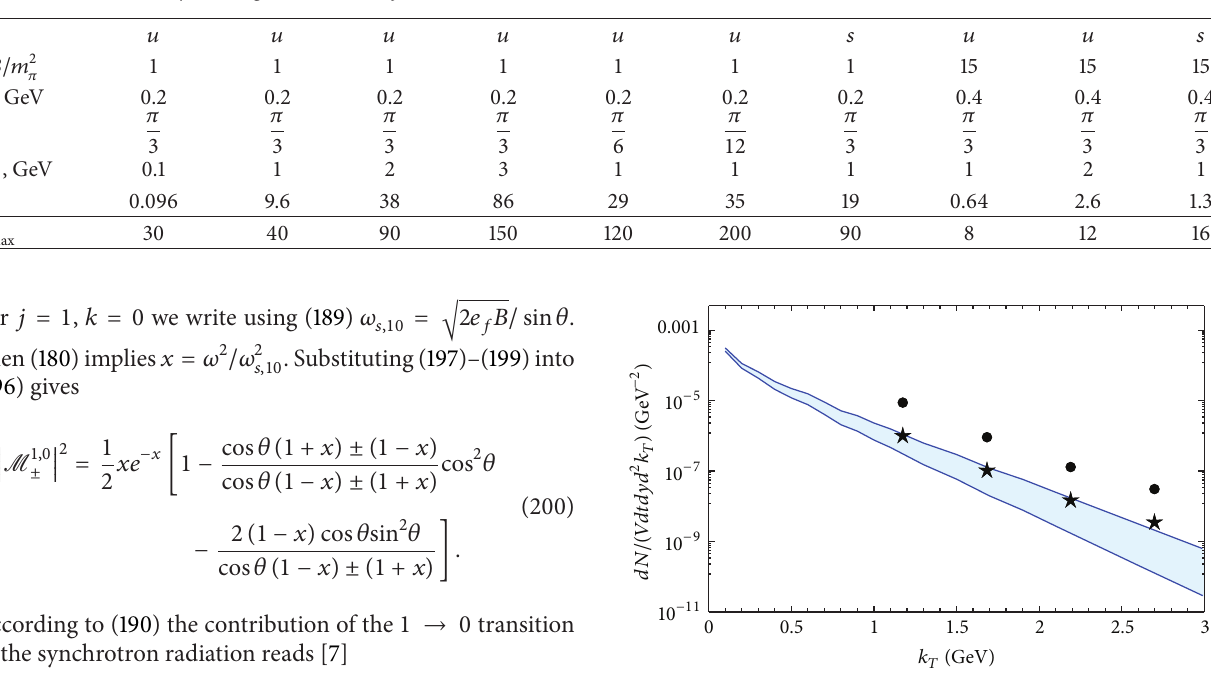
Table 1: The upper summation limit in (190) that yields the 5% accuracy. 𝑗 max is the highest Landau level of the initial quark that is taken into account at this accuracy. Throughout the table 𝑦 = 0 .